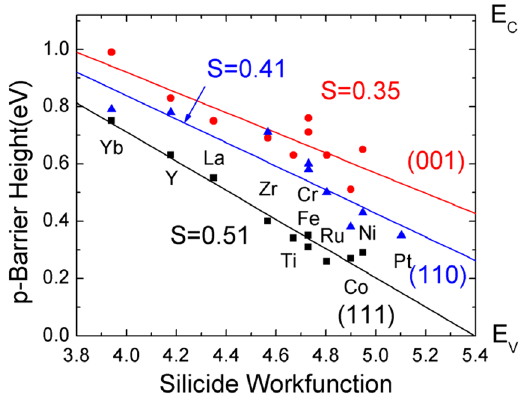
Figure 3. Calculated p-type Schottky barrier heights for Si/metal silicides, for (111), (110) and (100) interfaces, by the density functional supercell